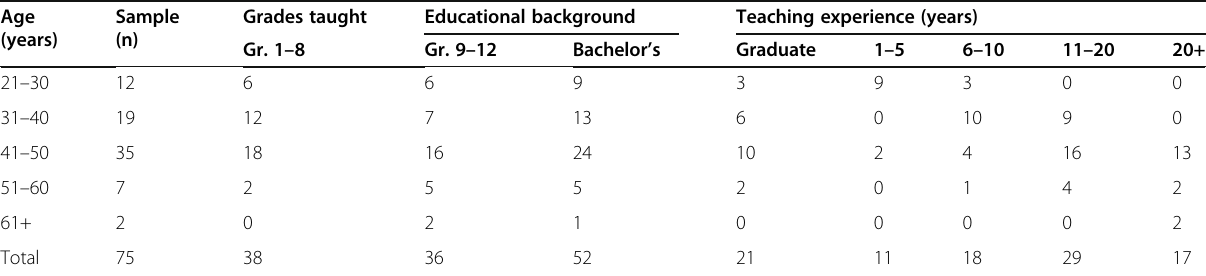
Table 1 Details of teachers ’ demographics: distribution of teachers within each age range Age Sample (years)